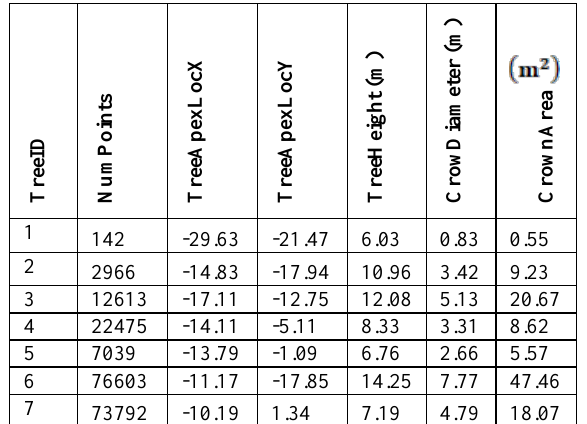
Table 1. Tree morphological parameters for seven trees from the study area. Each row represents the parameters for individual